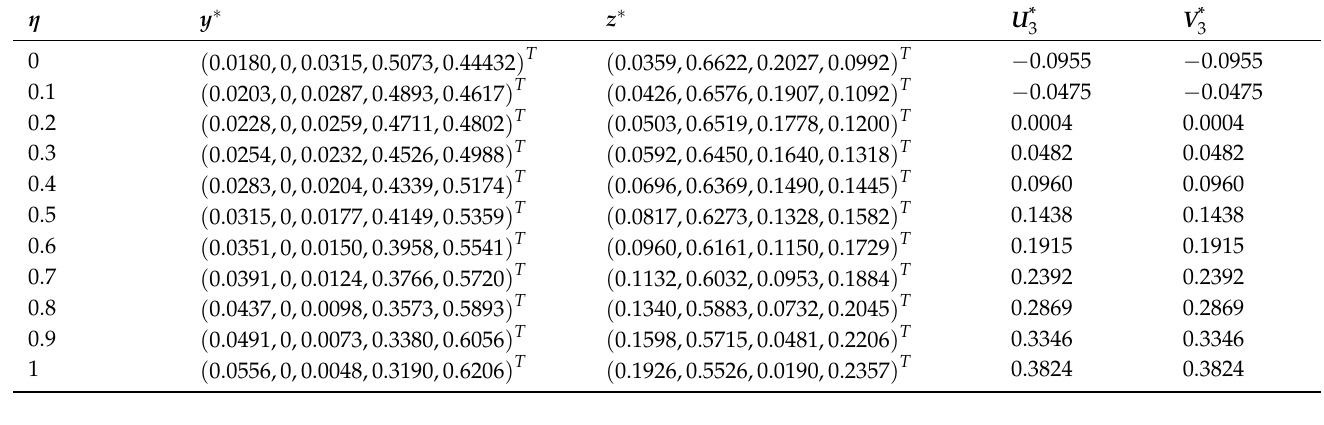
Table 4. Results obtained by hesitant fuzzy linguistic information for different values of η .